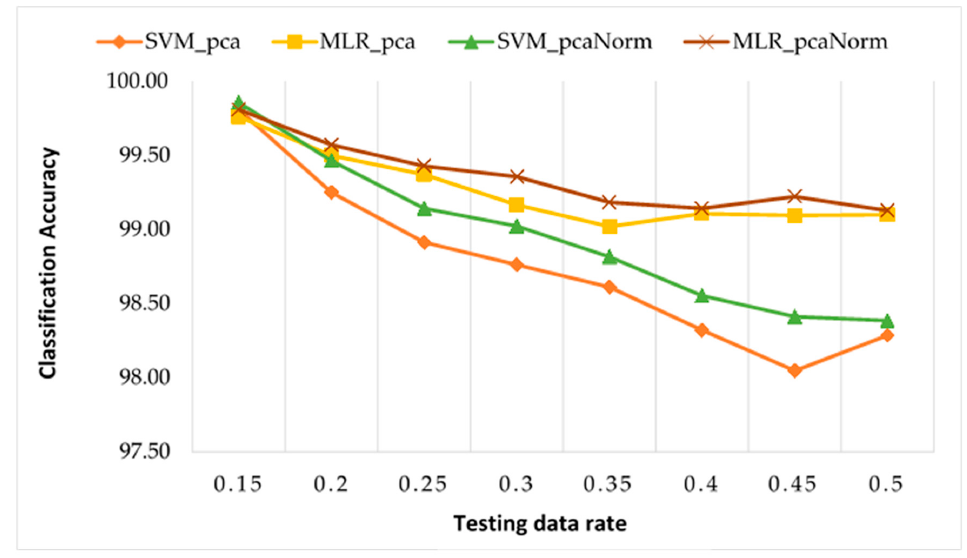
Figure 10. Comparisons of testing classification accuracies using our framework with SVM and MLR on normalised and unnormalised data.